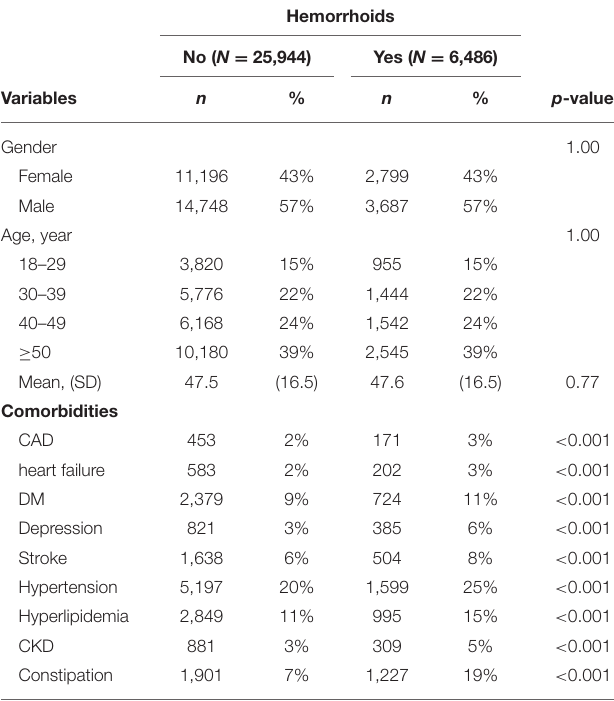
TABLE 1 | Baseline characteristics of patients with and without hemorrhoids.